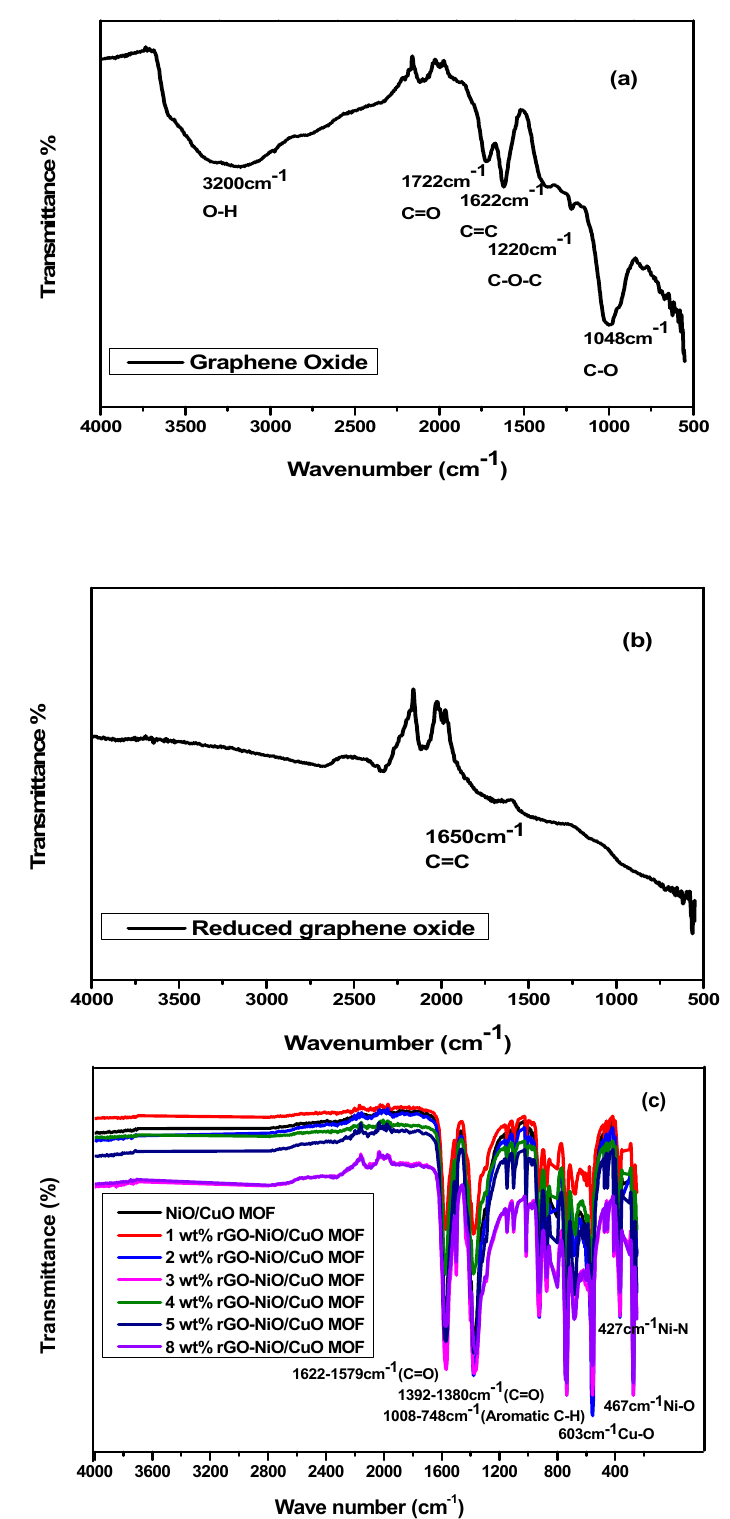
Figure 1. FTIR spectra of ( a ) graphene oxide (GO) ( b ) reduced graphene oxide (rGO) ( c ) nickel oxide/copper oxide metal–organic framework (NiO/CuO MOF) and its composites with 1 wt%, 2 wt%, 3 wt%, 4 wt% and 5 wt% rGO–NiO/CuO MOF.